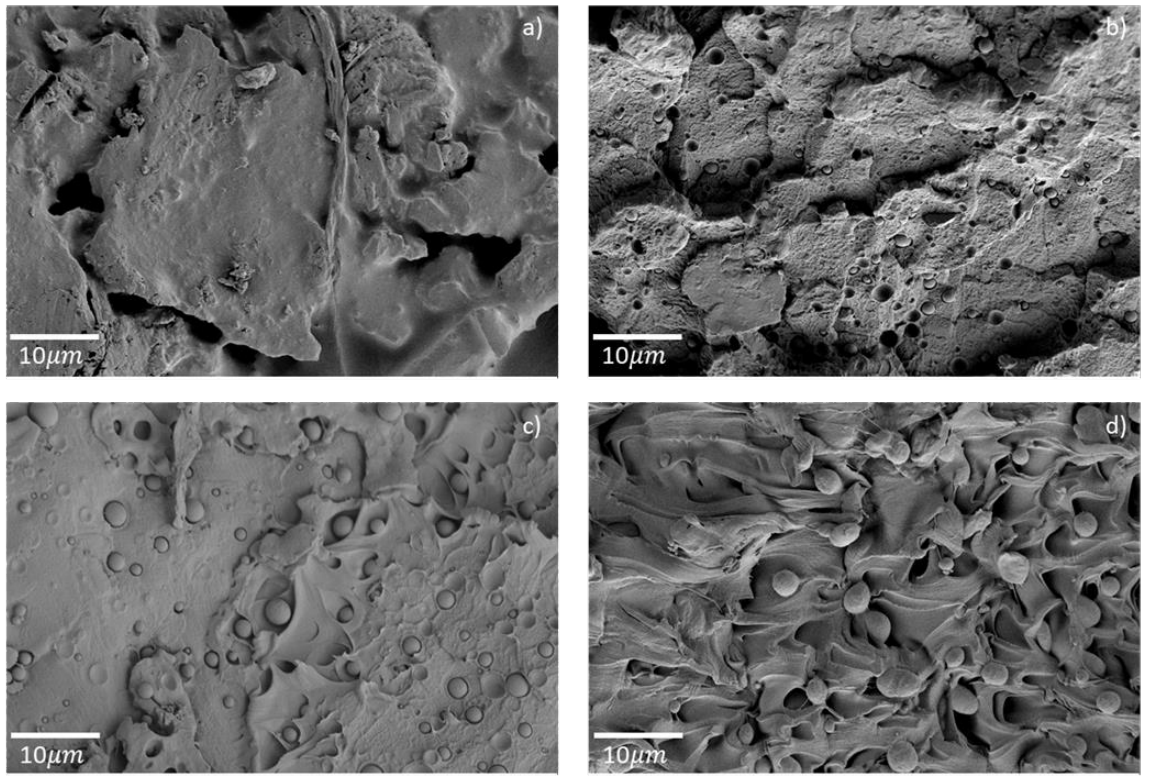
Figure 4. Electron micrographs of extruded filaments for ( a ) E-PET0, ( b ) E-PET2, ( c ) E-PET5, and ( d ) E-PET10.